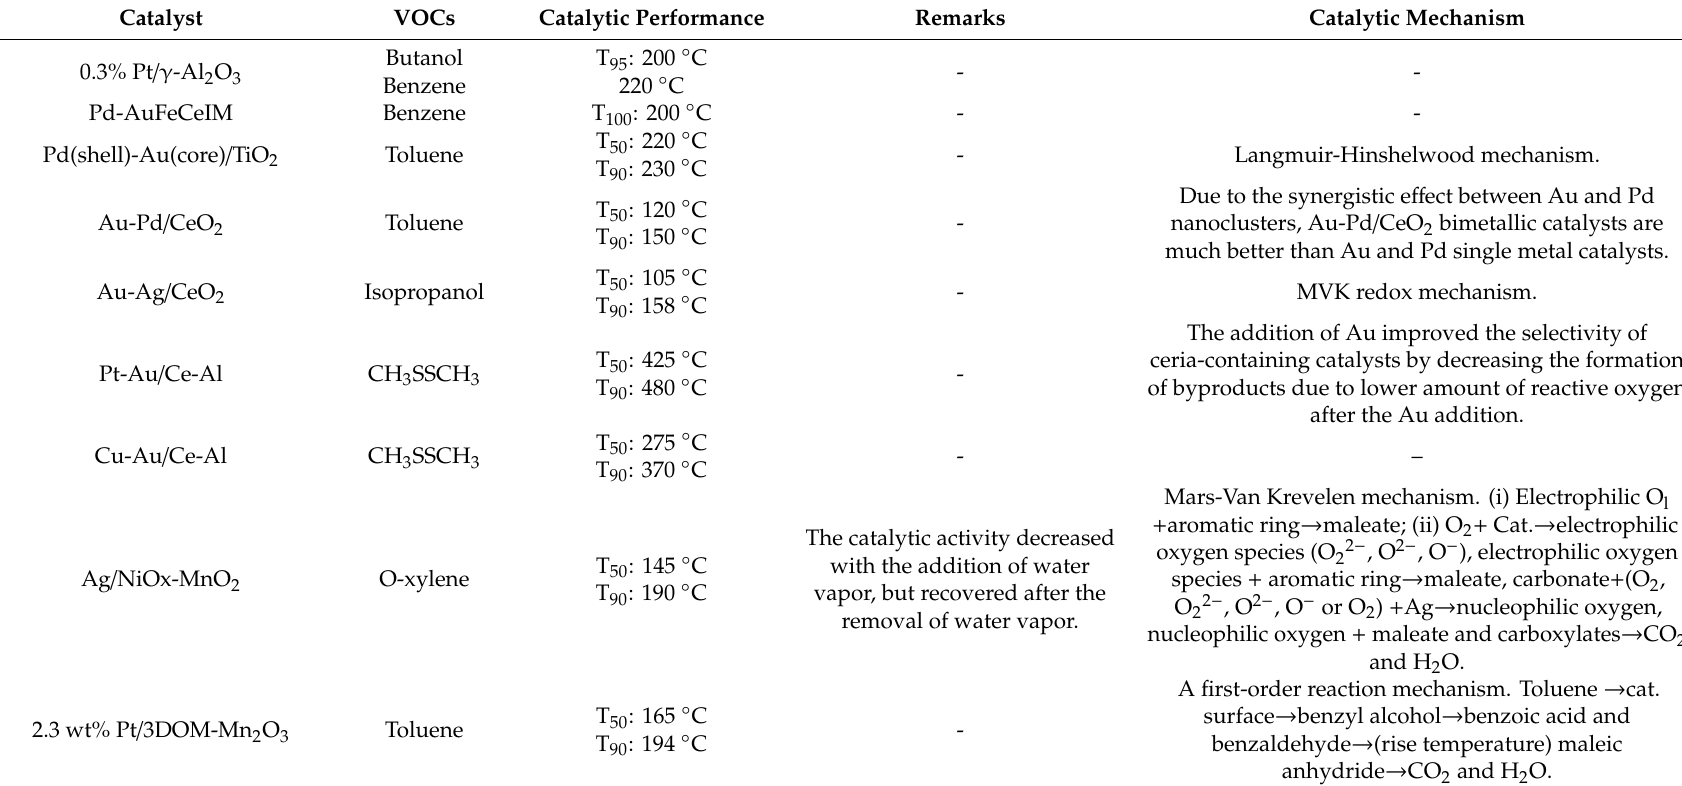
Table 5. Noble metal catalysts for catalytic combustion of